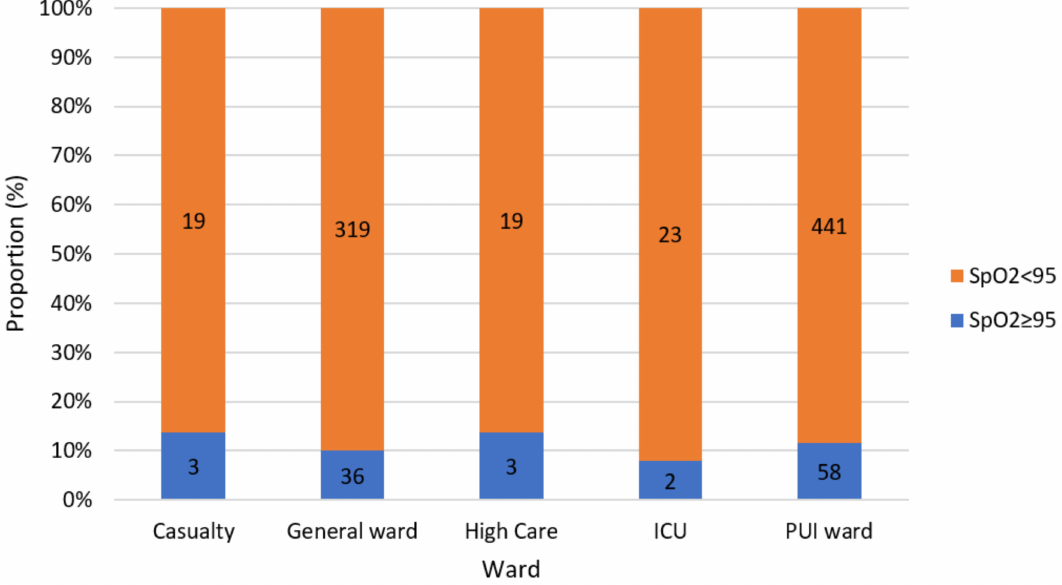
Figure 2. SpO2 level in COVID-19 hospitalised patients’ mortality by